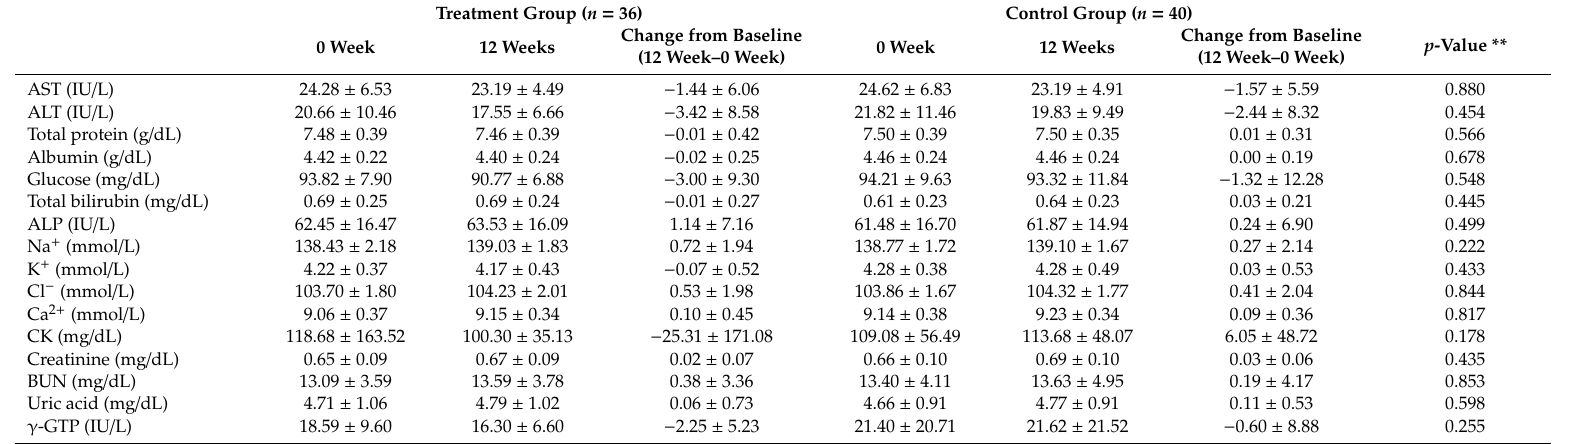
Table 4. Safety evaluation in blood chemistry between 0–12 weeks